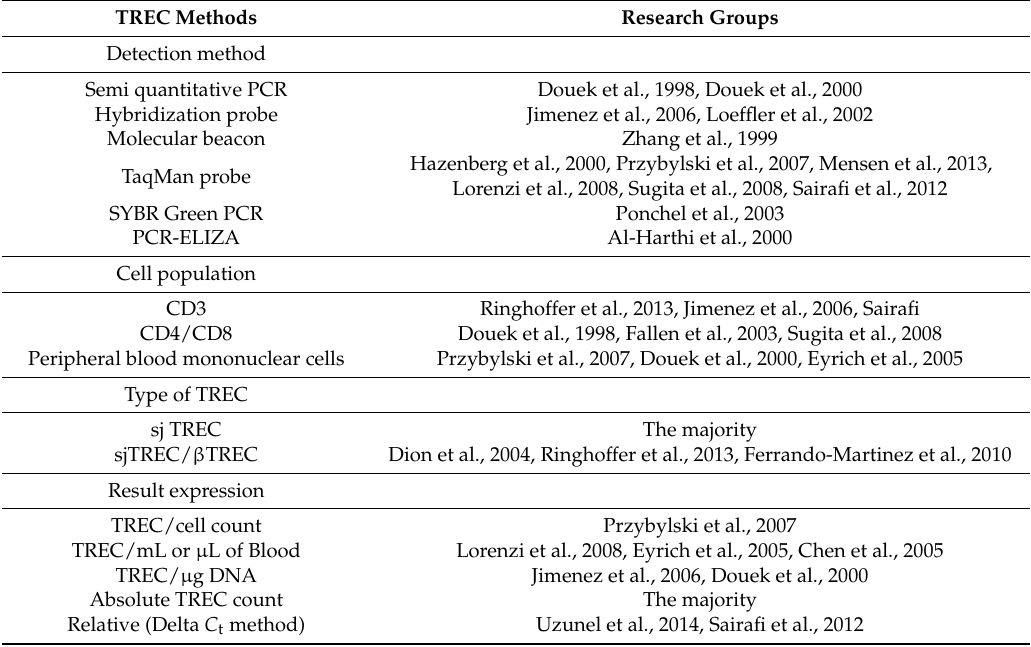
Table 3. Variabilities in the methods used for T cell receptor excision circles (TREC)